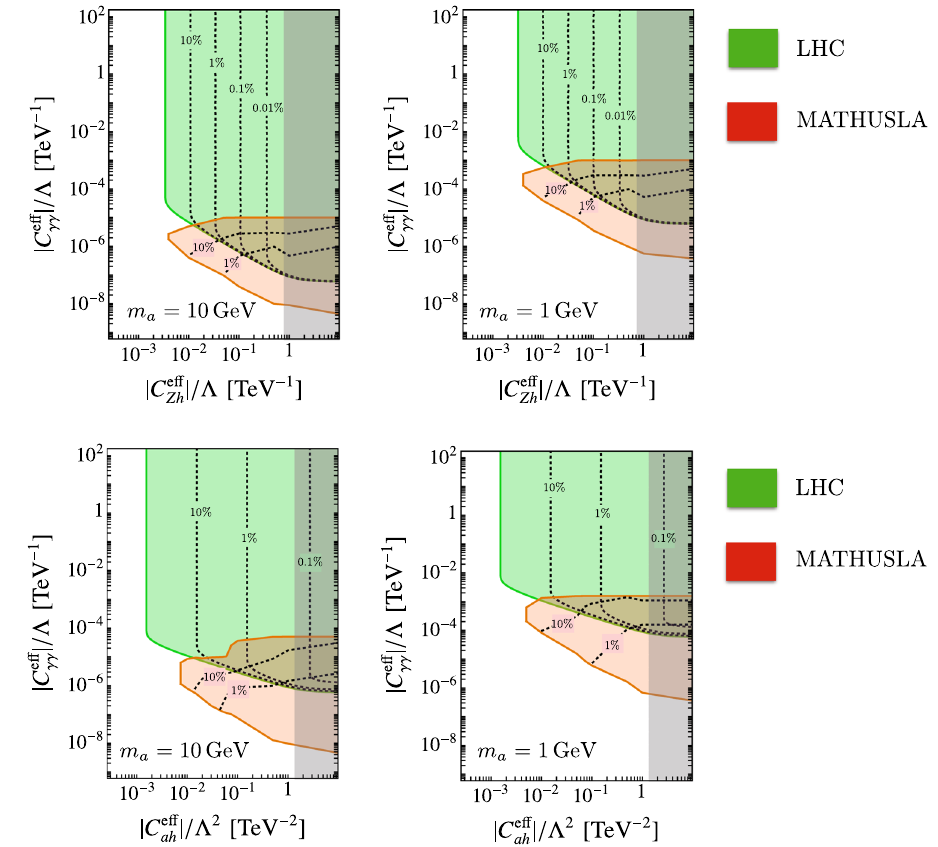
replaced by Br ( a → (cid:10) + (cid:10) − ) . In order to fully capture